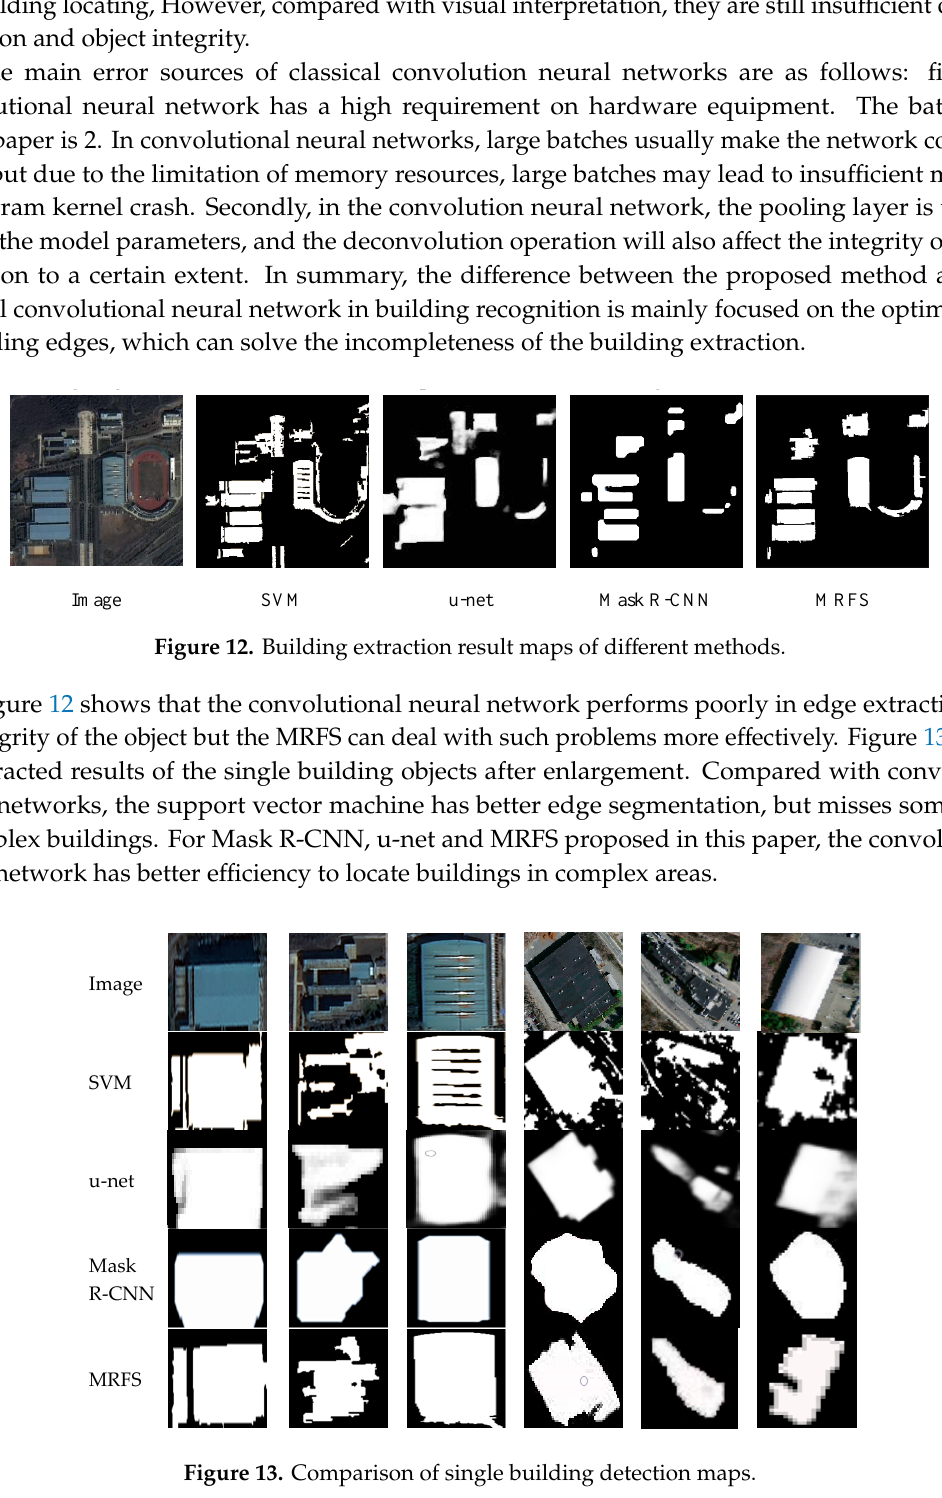
Figure 13. Comparison of single building detection maps.